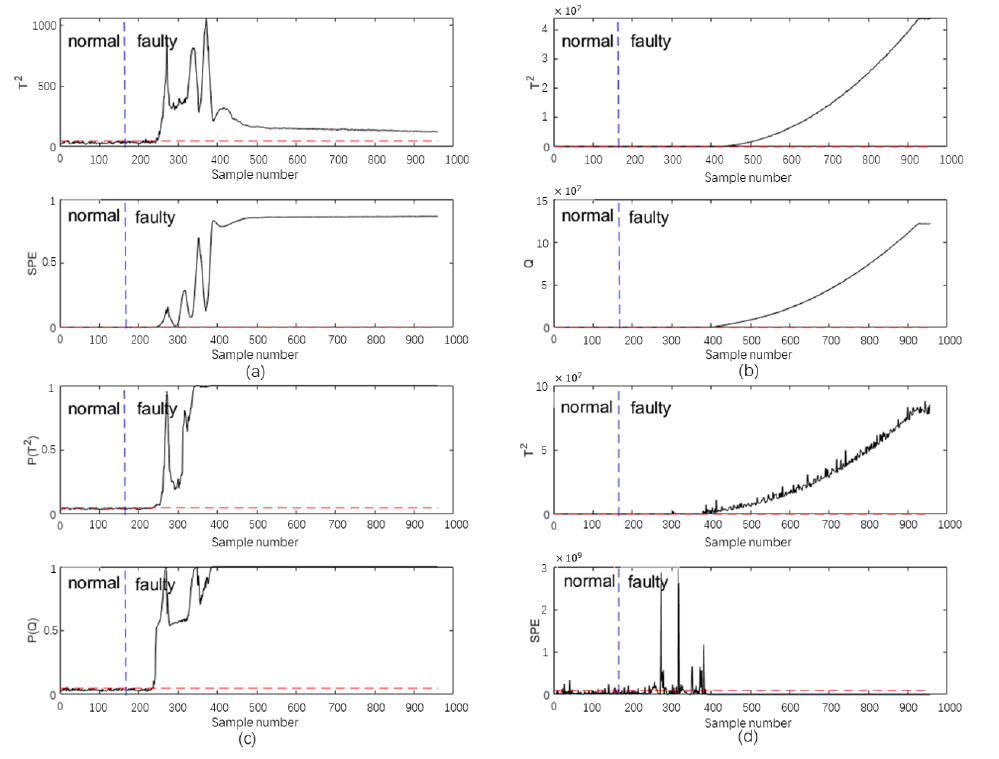
Figure 4. Monitoring results for TE fault 18. ( a ) DKPCA. ( b ) DeDPCA. ( c ) KCVA. ( d )